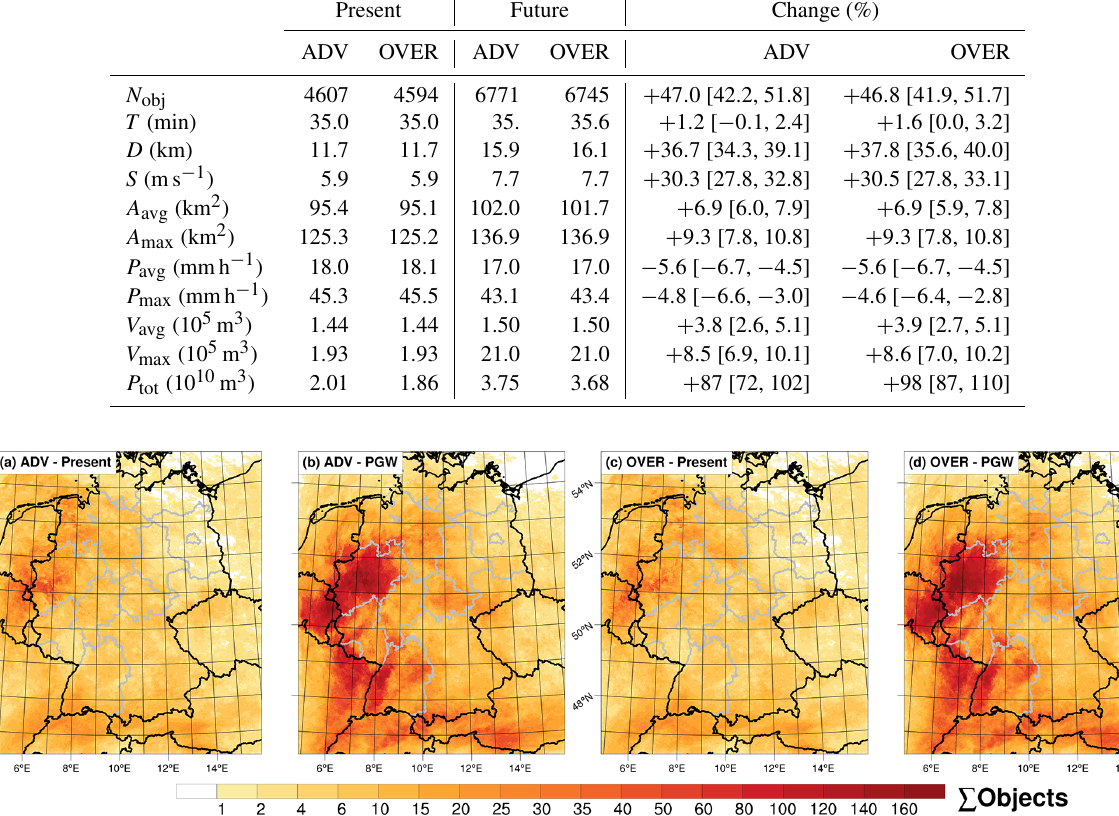
Figure 3. Total number of objects counted at each grid box for ADV in the (a) present and (b) PGW ensembles and OVER in the (c) present and (d) PGW ensembles. Results are based on the algorithms’ reference setup. The analysis region is as denoted by the dashed yellow boxes in Fig. 1. Note that a higher number of objects does not necessarily correspond to higher precipitation; e.g. one large system could cause more precipitation than multiple smaller